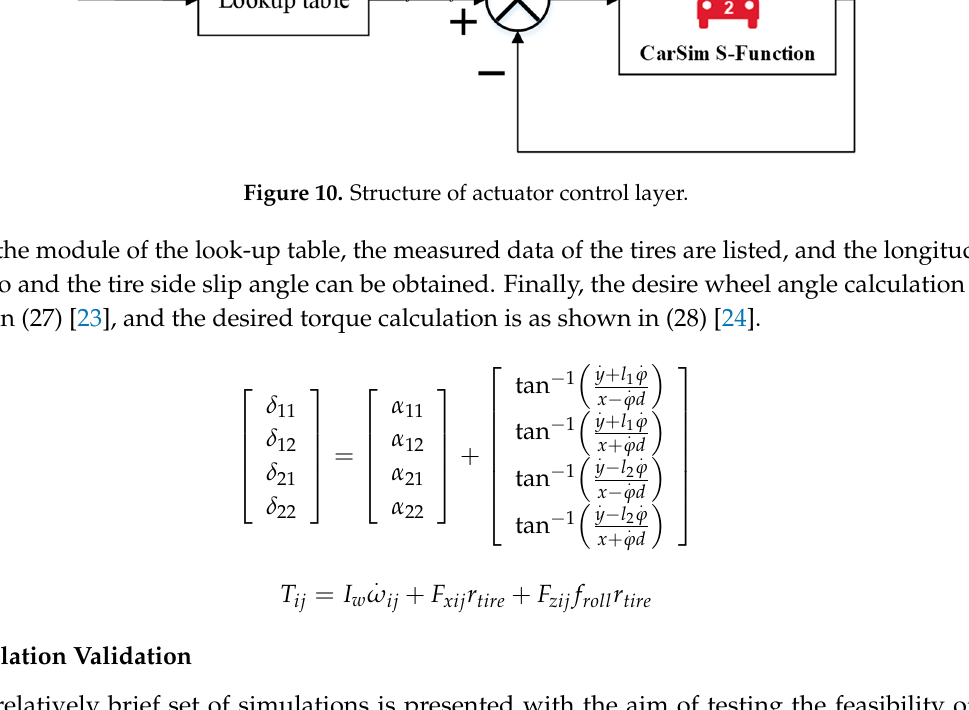
12 of 19 Figure 9. The schematic of linear polygon constraint.